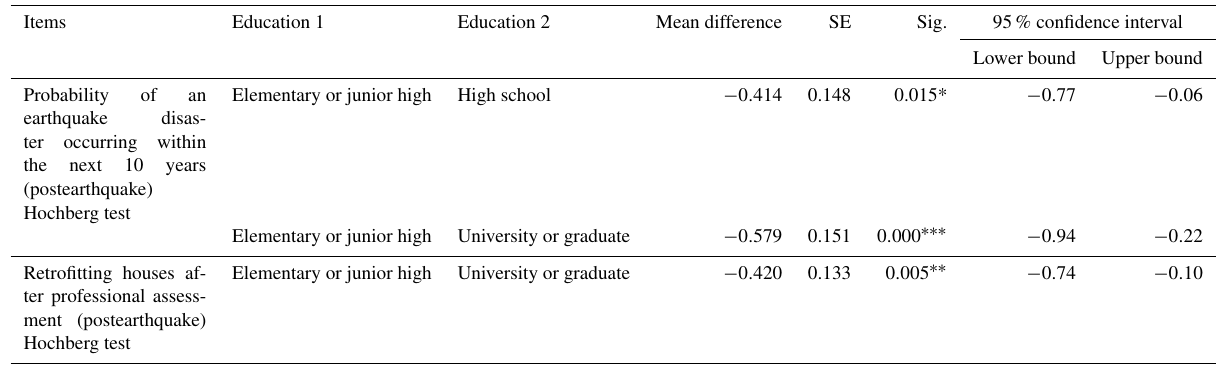
Table 6. Post hoc results for education (for the categories compared across the two education